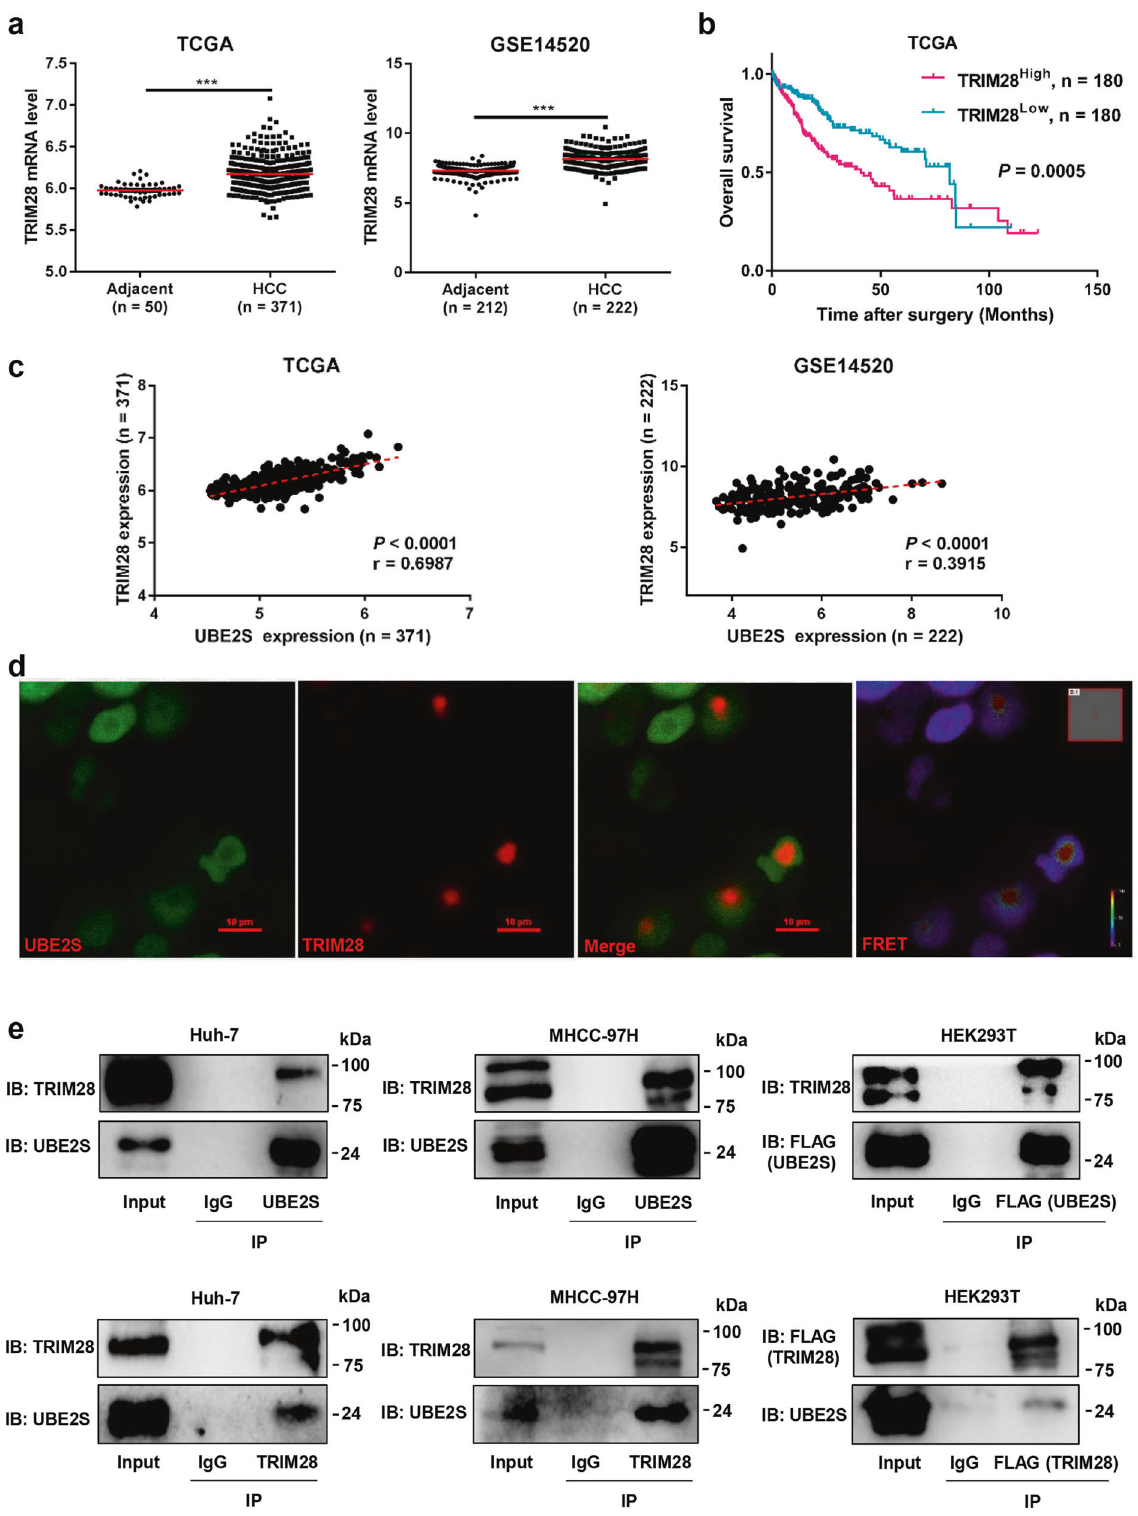
Fig. 3 UBE2S interacts with TRIM28 in the nucleus. a Expression of TRIM28 in HCC and adjacent tissues in TCGA and GSE14520 data sets. b OS rates of HCC patients with high or low TRIM28 expression evaluated by Kaplan – Meier analysis using TCGA data sets. c Correlation of UBE2S and TRIM28 expression in TCGA and GSE14520 data sets. d Interaction between UBE2S and TRIM28 in HEK293T cells transiently transfected with UBE2S-EGFP and TRIM28-DsRed2 plasmids detected by FRET. e Endogenous or exogenous interaction of UBE2S and TRIM28 detected by co-immunoprecipitation and western blot analysis. Two-tailed Student ’ s t tests were used to test the signi fi cance of differences between two groups ( a ). Kaplan – Meier curves of overall survival of HCC patients were determined by the log-rank test ( b ). Pearson ’ s correlation test was used to assess the correlation between UBE2S mRNA expression and TRIM28 mRNA expression ( c ). *** P < 0.001